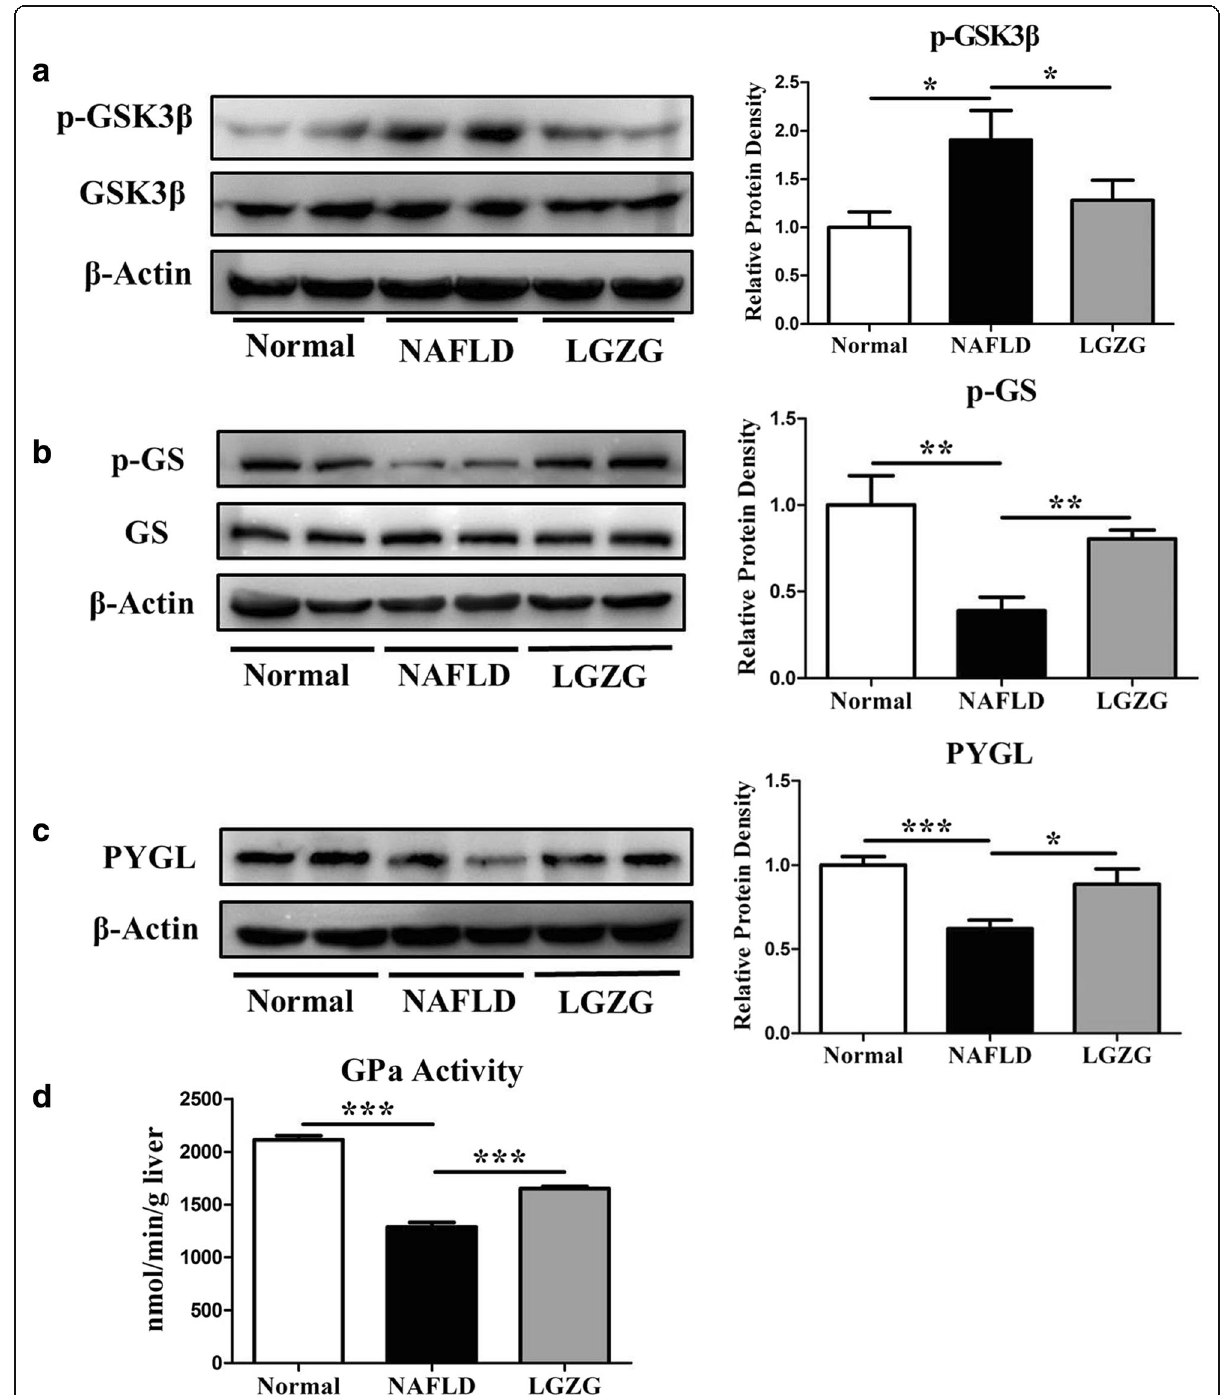
Fig. 3 LGZG regulated key molecules of Glycogen metabolism in NAFLD rats. Western blot detected ( a ) p-GSK3 β and GSK3 β protein expression, ( b ) p-GS and GS protein expression, ( c ) PYGL protein expression, ( d ) GPa activity was analyzed by ELISA. Data were presented as means ± SEM ( n = 8 per group). * P < 0.05, ** P < 0.01, *** P <